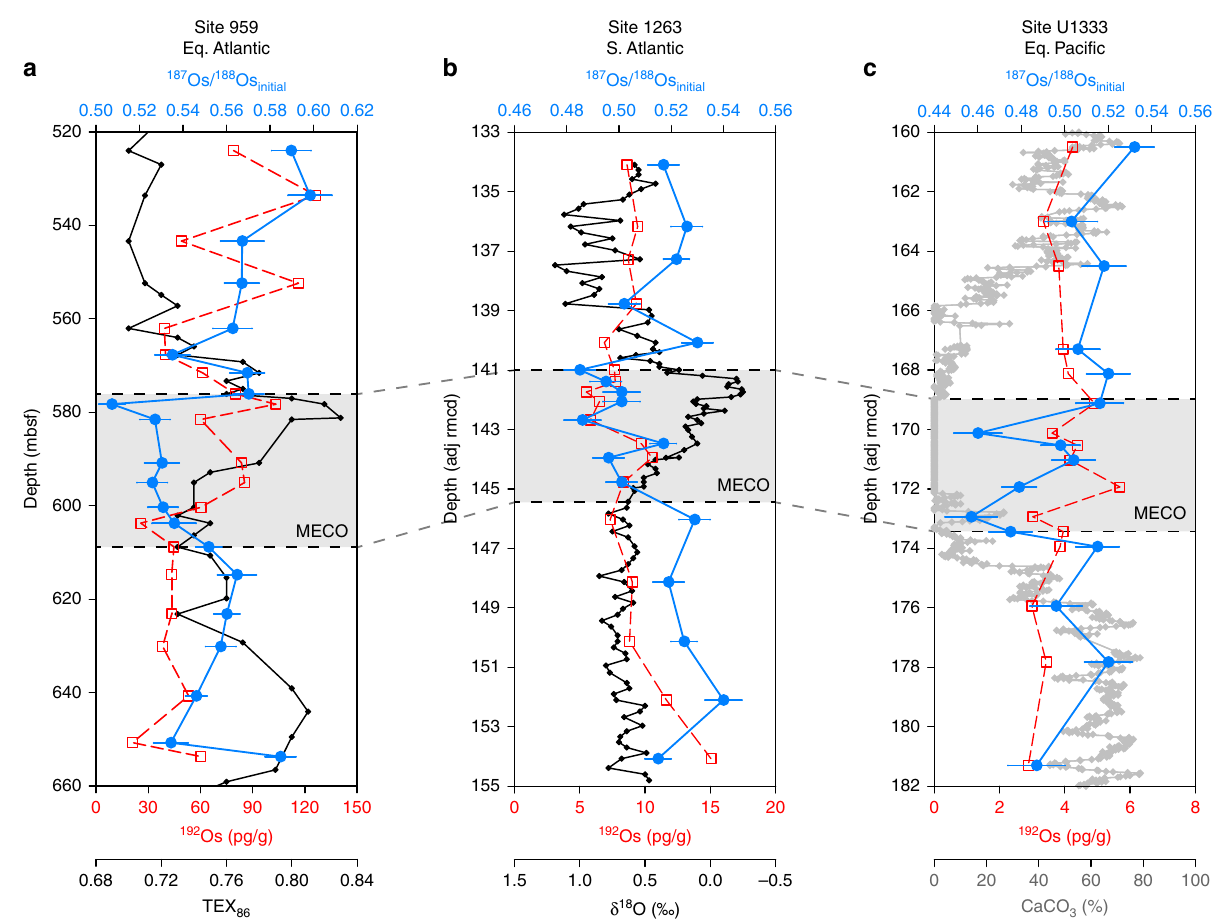
Fig. 1 Os i values (in blue) and 192 Os concentrations (in red) for the analyzed middle Eocene sediments from the three different sites. a ODP Site 959; b ODP Site 1263; c IODP Site U1333. The MECO interval is de fi ned based on TEX 86 values for Site 959 (in black; Cramwinckel et al. 13 ) and bulk carbonate stable oxygen isotope ratios ( δ 18 O) for Site 1263 (in black; Bohaty et al. 10 ). The MECO is characterized by low carbonate content at Site U1333 (in grey; Westerhold et al. 84 ). The error bars indicate fully propagated analytical uncertainties (2 σ